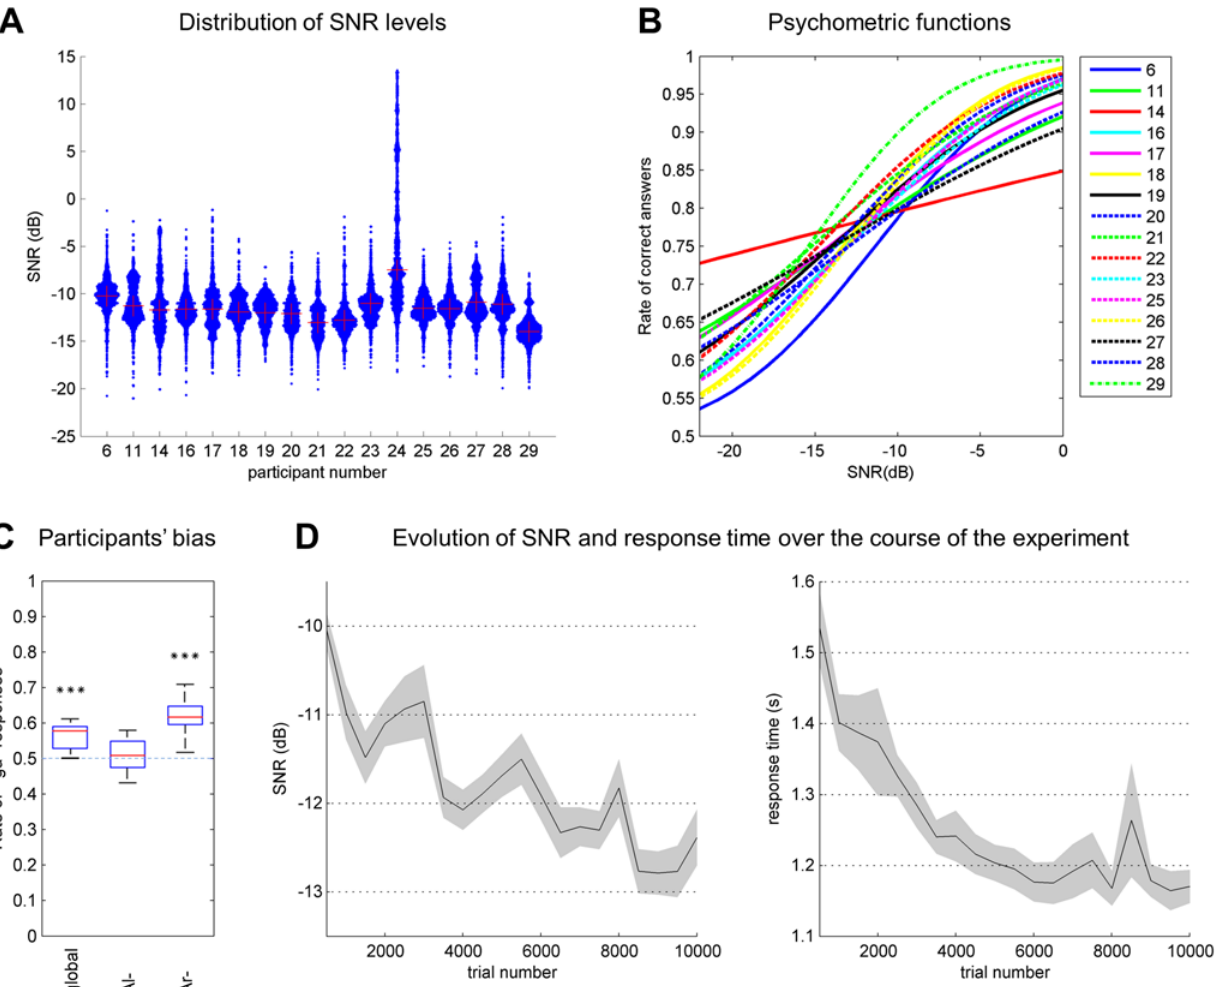
Fig 3. Overview of performance across all participants. A. Distribution of SNR levels for all participants (N = 17), with the mean SNR indicated with crosses. The width of each histogram is proportional to the number of trials ran at the corresponding SNR. B. Psychometric functions for participants included in the analysis (N = 16). C. Participants ’ bias towards response ‘ ga ’ (N = 16) over the entirety of the experiment ( “ global ” ) and in conditions Al- and Ar-. Conditions with a significant bias (i.e., rate of ‘ ga ’ responses differing significantly from the level of 0.5 based on a random distribution, blue line) are indicated by asterisks. D. Evolution of the SNR and response time over the course of the experiment for sessions of 500 trials. Mean for the participants collectively (N = 16) with